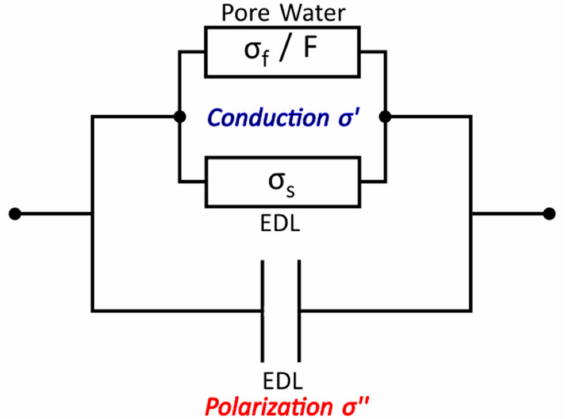
Figure 3. Simplified circuit diagram of charge transport in saturated rock [56]. The in-phase com- ponent of conductivity ( σ (cid:48) ) is controlled by the ratio of fluid conductivity ( σ f ) and the formation factor (F), and by surface conductivity ( σ s ) along the electric double layer (EDL) on grain or phase boundaries. The quadrature component of conductivity ( σ ”) is controlled by polarization and other phenomena in the EDL, including surface conductivity